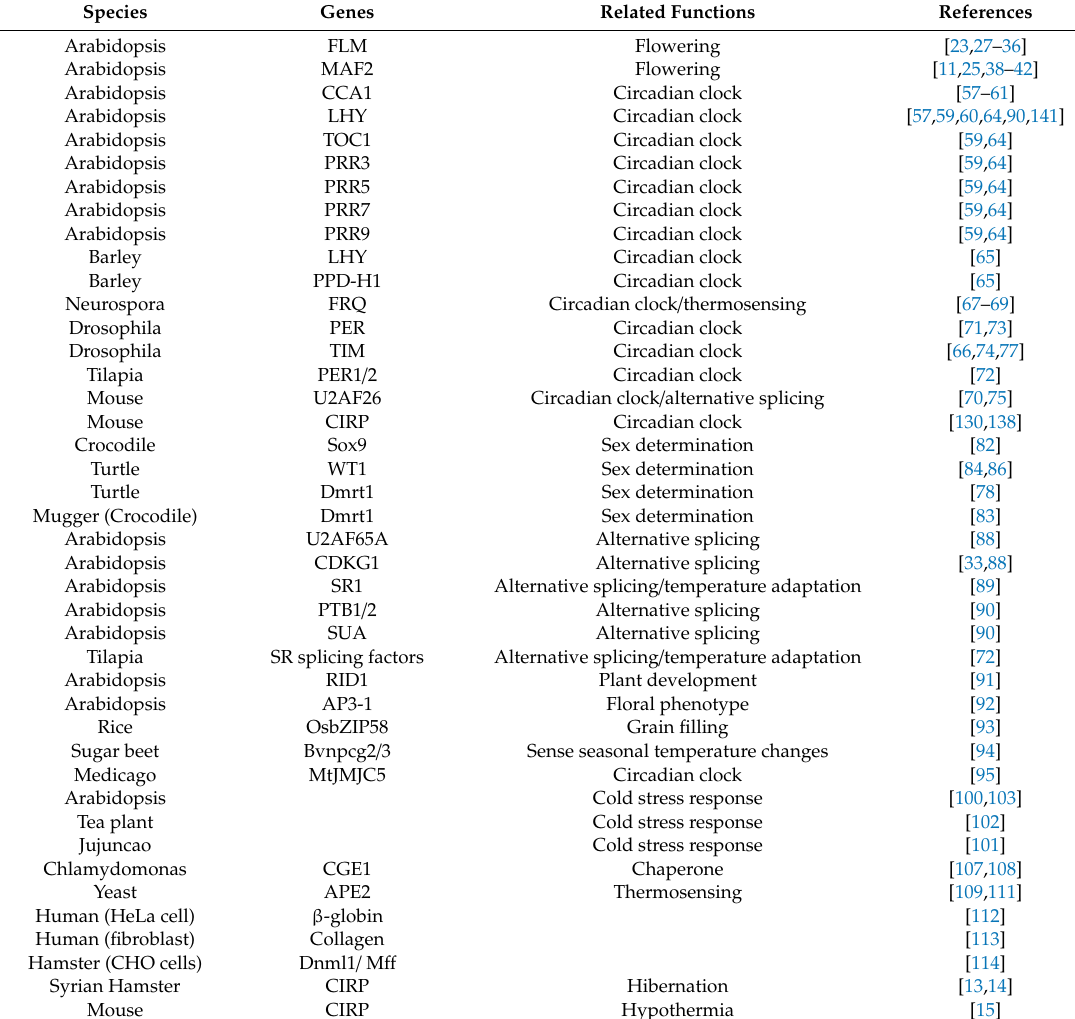
Table 1. Temperature-dependent alternative